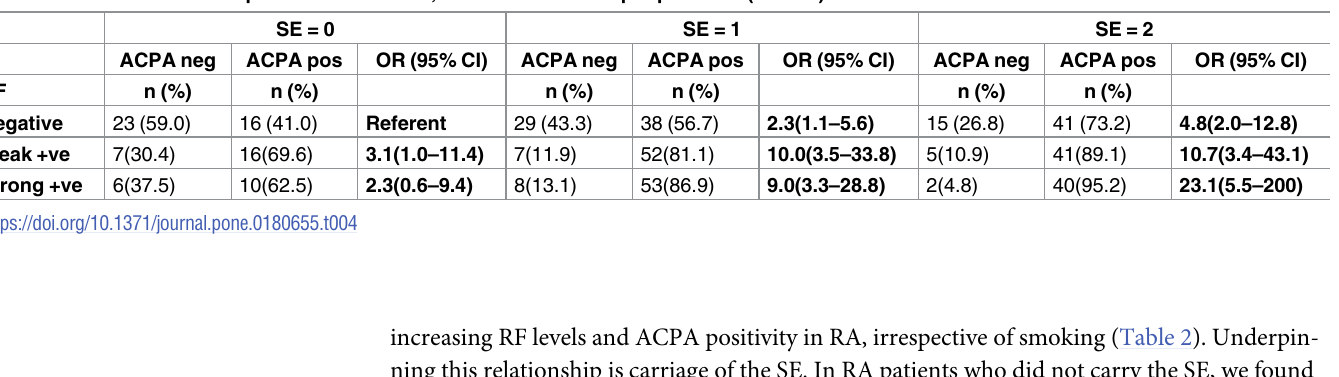
Table 5. Cohort 2 multivariate logistic regression analysis of variables associated with anti-CCP positivity in RA (n = 386).